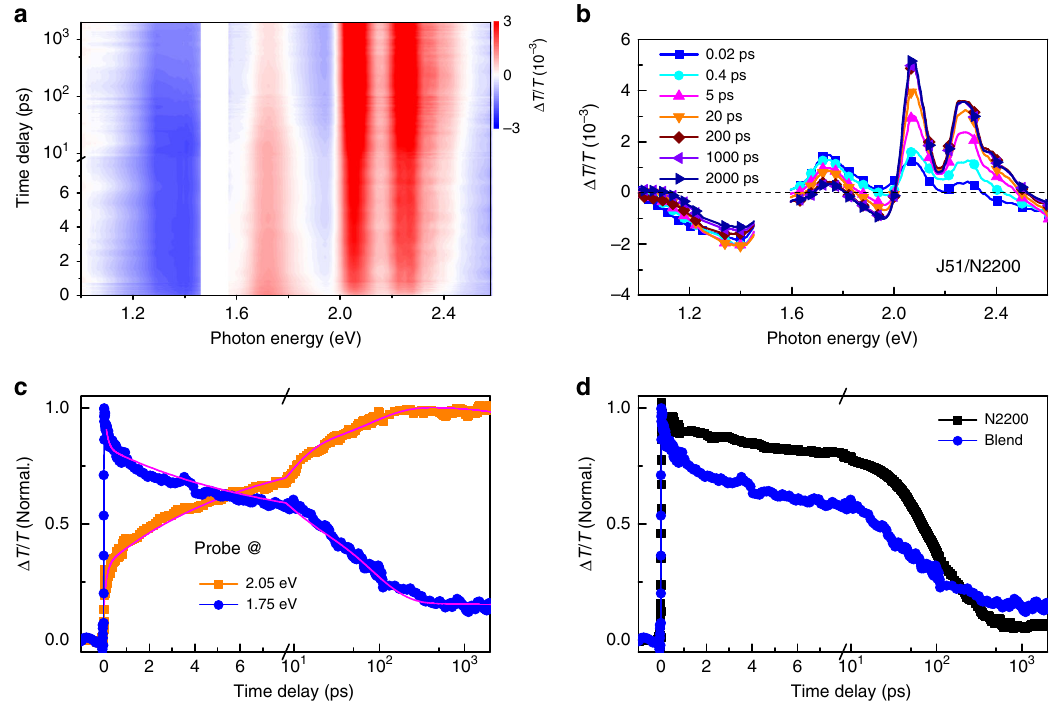
Fig. 2 Hole transfer dynamics in a J51/N2200 blend fi lm. a TA signal recorded from a J51/N2200 blend fi lm with pump photon energy of 1.75 eV. b TA spectra from the blend fi lm recorded at different time delays. c The GSB signal of the acceptor N2200 at 1.75 eV compared with the GSB signal of the donor J51 at 2.05 eV. The multi-exponential fi ts show that the hole transfer lifetime is about 3.2 ps. d The GSB signal of the acceptor N2200 at 1.75 eV decays much faster in the blend fi lm than in the neat fi lm of N2200